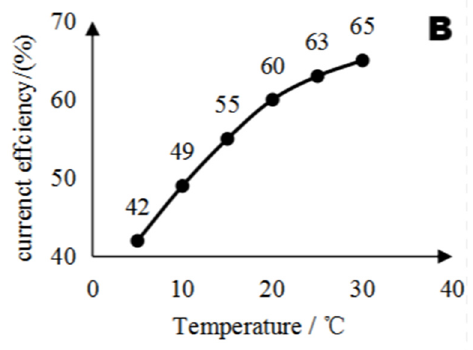
Figure 1. Relationship between current efficiency and different factors. ( A ) The relationship be ‐ tween current efficiency and concentration; ( B ) The relationship between current efficiency and temperature; ( C ) The relationship between current efficiency and oxidation time; ( D ) The relation ‐ ship between current efficiency and current density. 2.3. Simulation Model Establishment The current distribution and film thickness of the anodic oxidation process were sim ‐ ulated using the secondary current distribution interface in the electrochemical module of Comsol. In this study, the 6061 aluminum alloy specimen size was 20 mm × 20 mm × 3 mm, the oxidation tank was a 10 L beaker with an internal diameter of 255 mm, the sul ‐ phuric acid solution height was 260 mm and the cathode plate size was 100 mm × 100 mm × 3 mm. A simplified model is shown in Figure 2.